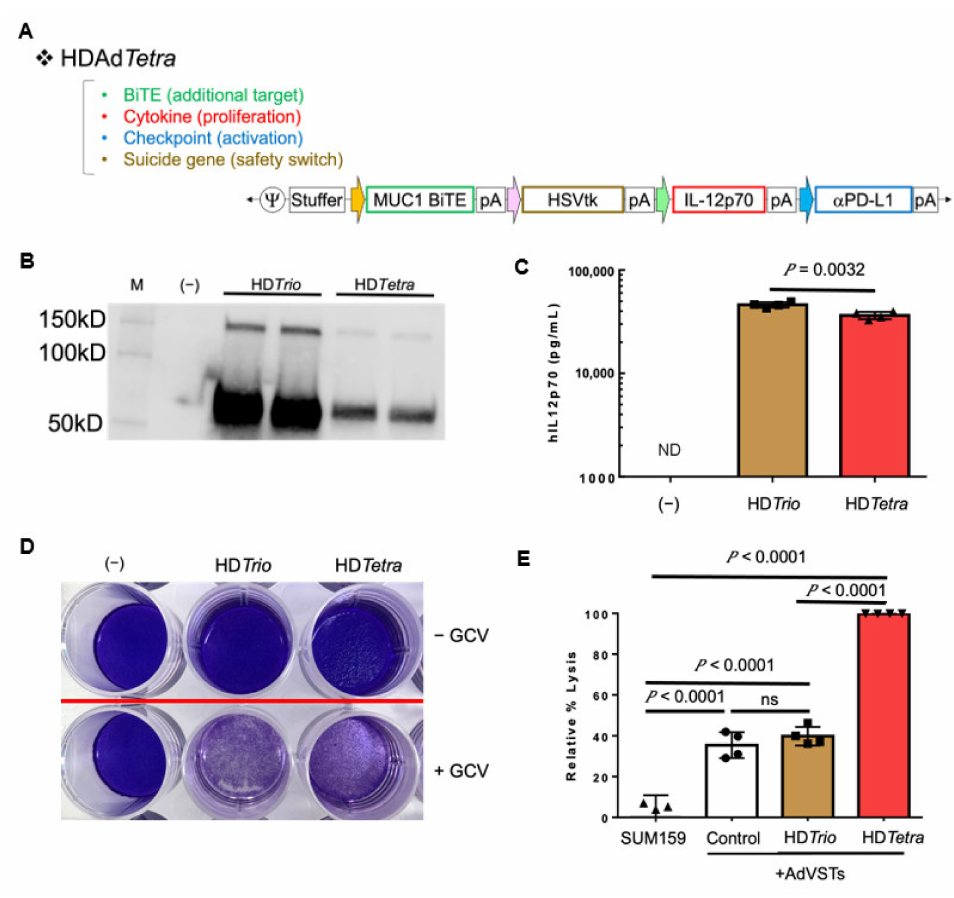
Figure 5. HDTetra enables simultaneous expression of four transgenes. ( A ) Schematic structure of HD5/3 Tetra encoding the MUC1.BiTE, HSVtk safety switch, human IL12p70, and anti-PDL1 minibody expression cassettes. ( B ) A549 cells were infected with 500 vp/cell of HD5/3 tkTrio (HD5/3 Trio ) or HD5/3 Tetra . Media were collected 48hrs post-infection. Medium samples were subjected to western blotting for PDL1 minibody, which is detected by anti-HA antibody. Uncropped blot of Figure 5B is shown in Figure S6 ( C ) A549 cells were infected with 100 vp/cell of HD5/3 Trio or HD5/3 Tetra . Media were collected 48 h post-infection. Medium samples were assessed for human IL12p70 by ELISA assay. Data are presented as means ± SD ( n = 4). ND = Not detectable. ( D ) A549 cells were infected with 500 vp/cell of HD5/3 Trio or HD5/3 Tetra . Media containing ganciclovir (GCV) was added to denoted wells 24 h post-infection and replaced daily. After 8 days viable cells were fixed and stained with crystal violet. Representative image presented. ( E ) A549 cells were infected with 500 vp/cell of HD5/3 Trio or HD5/3 Tetra , supernatants were collected 48 h post-infection. Supernatant containing MUC1.BiTE were applied to SUM-159 cells expressing ffLuc in the presence of adenovirus-specific T-cells (AdVSTs) (E:T = 1:5). Cancer cells were harvested 72 h post-co-culture and viable cells were analyzed by luciferase assay. Data are presented as means ± SD ( n = 4), ns-non